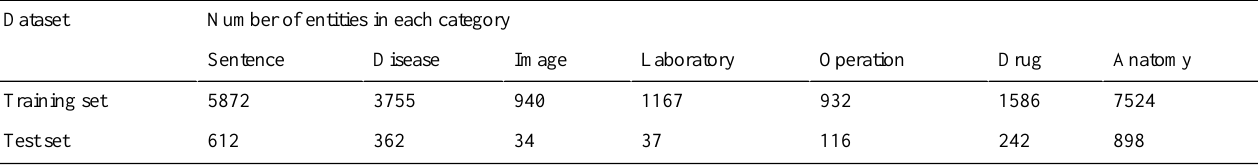
Table 3. The distribution of entities in the China Conference on Knowledge Graph and Semantic Computing (CCKS)-2019 clinical named entity recognition (CNER)